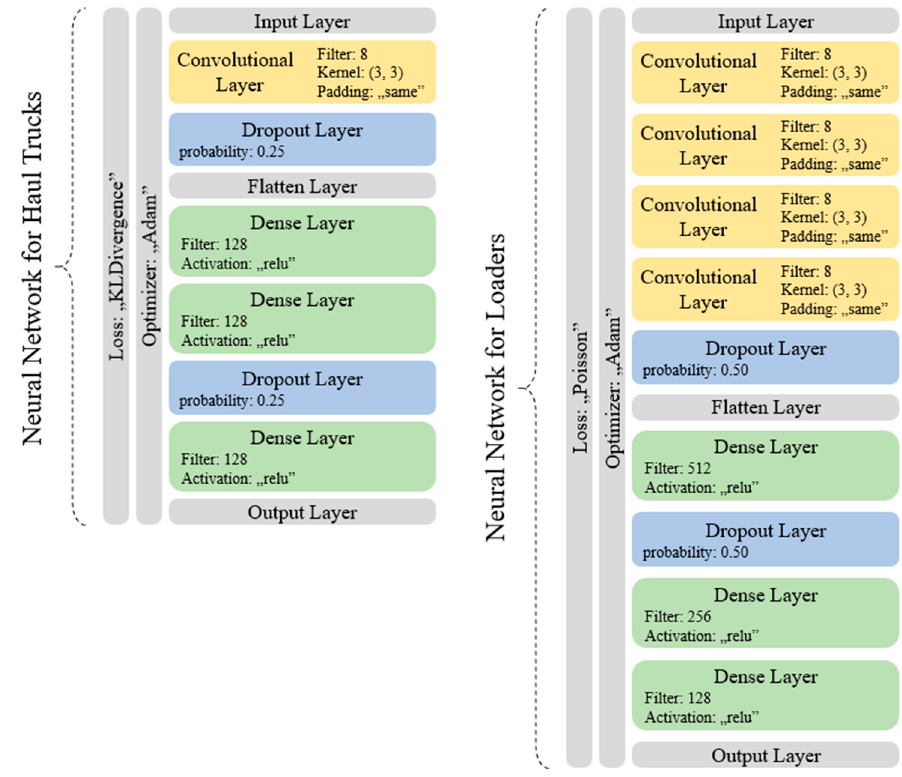
Figure 8. Final structures and hyperparameters of both neural networks acquired during the opti- mizations described in construction process. mizations described in construction